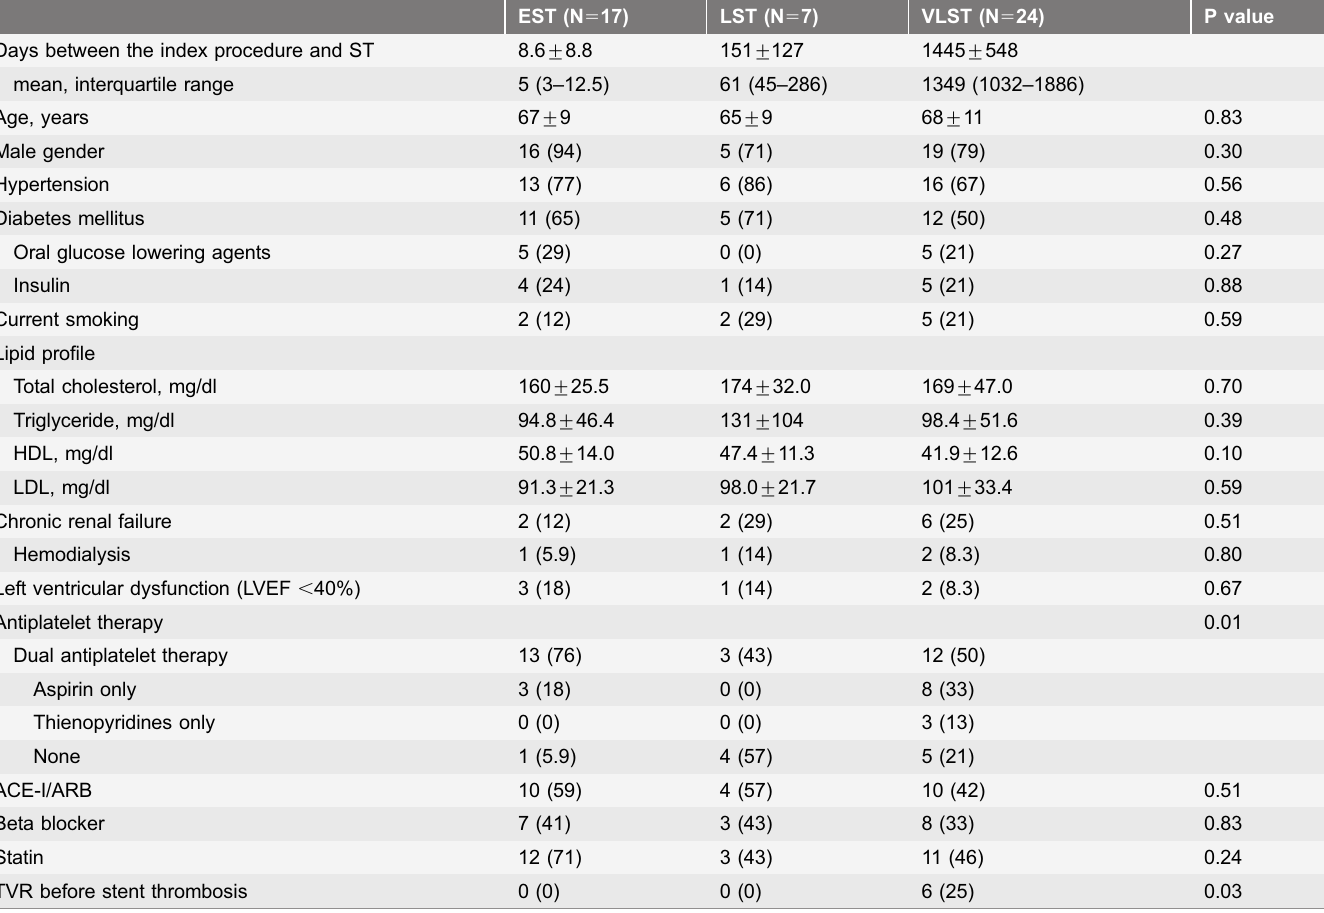
Table 1. Patient Characteristics at Time of Stent Thrombosis According to the Timing of Stent